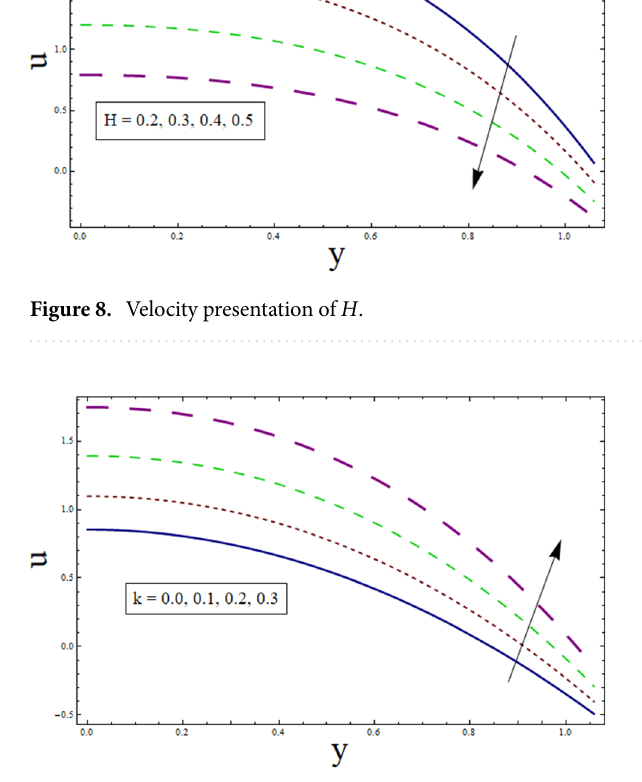
Figure 9. Velocity presentation of k .